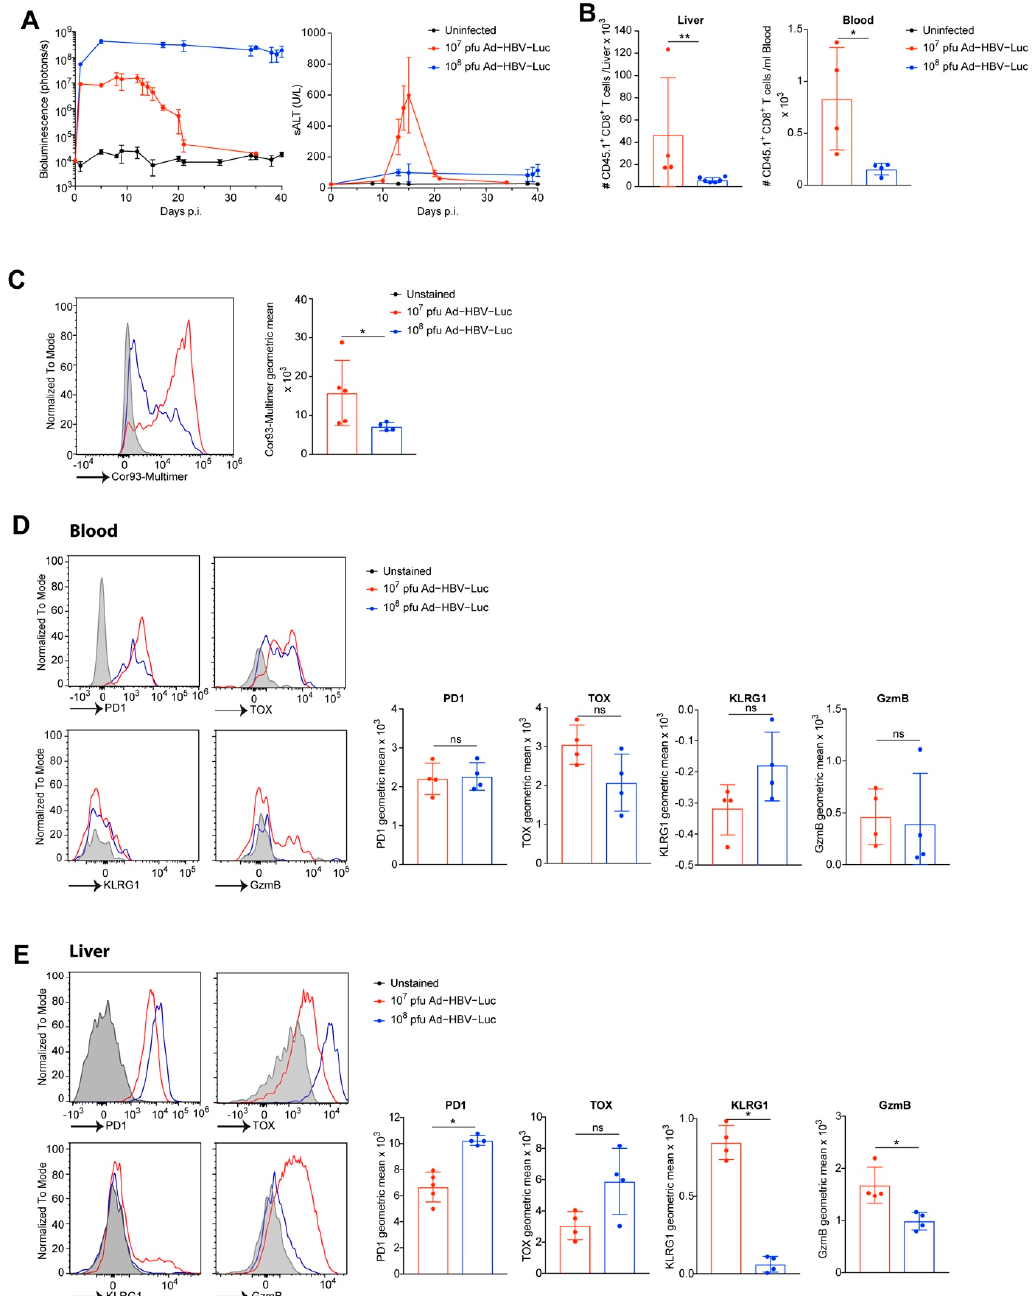
Figure 5. TCR transgenic CD8 T cells enhance the sensitivity of CD8 T cell phenotyping. ( A – E ) C57Bl/6 mice were adoptively transferred with 10 5 naïve Cor93-specific CD8 T cells bearing the congenic marker CD45.1 and infected i.v. with acute self-limited (10 7 pfu, red) or chronic infectious dose (10 8 pfu, blue) of Ad-HBV-Luc. Lymphocytes from liver and blood were isolated at day 15 after infection. ( A ) Quantification of virus-infected hepatocytes by bioluminescence signal in the liver and quantification of liver damage by sALT level of infected mice at indicated time points. Detection limit was determined by measurement of uninfected mice (black). ( B ) Quantification of numbers of transferred CD45.1 CD8 T cells isolated from liver and blood. ( C ) Flow cytometric analysis of Cor93-specific T cell receptor expression on transferred CD45.1 CD8 T cells. ( D , E ) Representative histograms and quantification of indicated marker expression on/in transferred CD45.1 CD8 T cells (gated on living CD45.1 CD8 T cells) isolated from ( D ) blood or ( E ) liver. ( A – E ) Mean and SD are shown ( n = 5). The experiments were performed two times